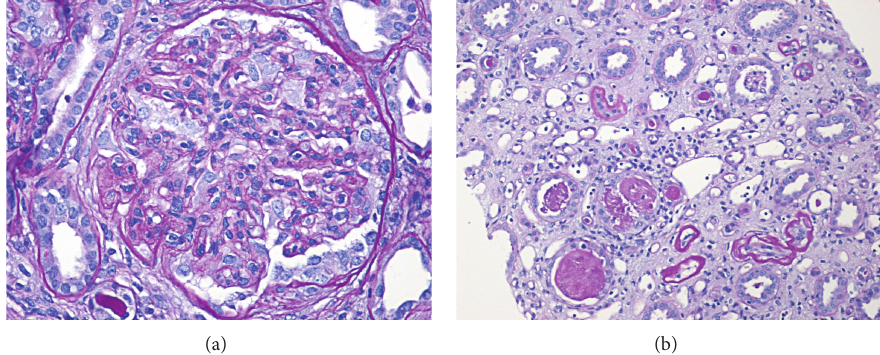
Figure 2: Light microscopic finding of kidney biopsy. PAS at 400x shows glomerulus with globally increased mesangial matrix and cellularity and segmental attachment to Bowman’s capsule (a). The glomerular capillary loops show patchy endocapillary proliferation and focal mononuclear cell infiltration. No necrosis or crescents are seen in glomeruli, and the interstitium shows extensive fibrosis and patchy tubular atrophy. PAS at 200x demonstrates tubules containing intraluminal casts with smooth borders and flattening and sloughing of tubular epithelial cells (b).